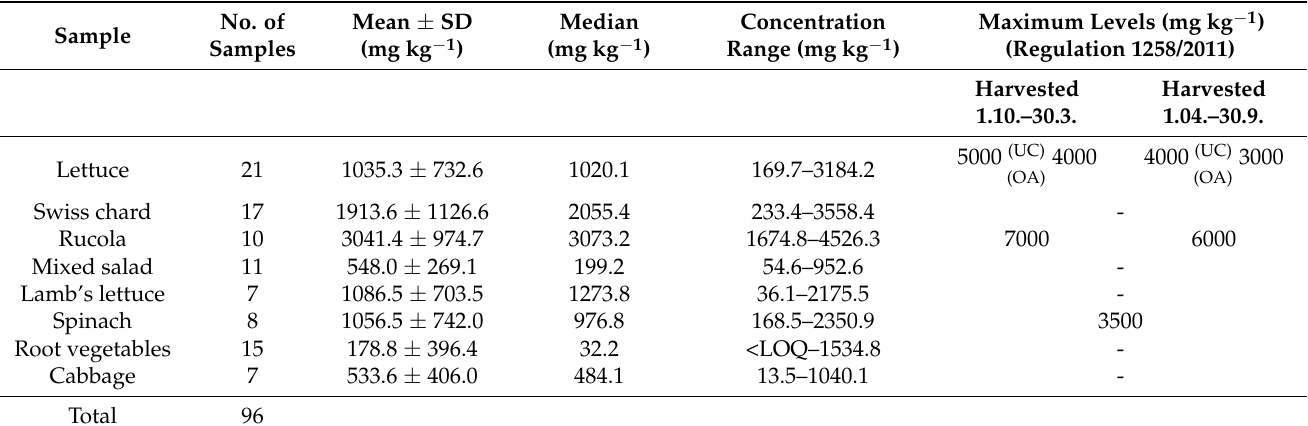
Table 1. Distribution and levels of nitrate (mg kg − 1 ) in the different types of vegetables in this